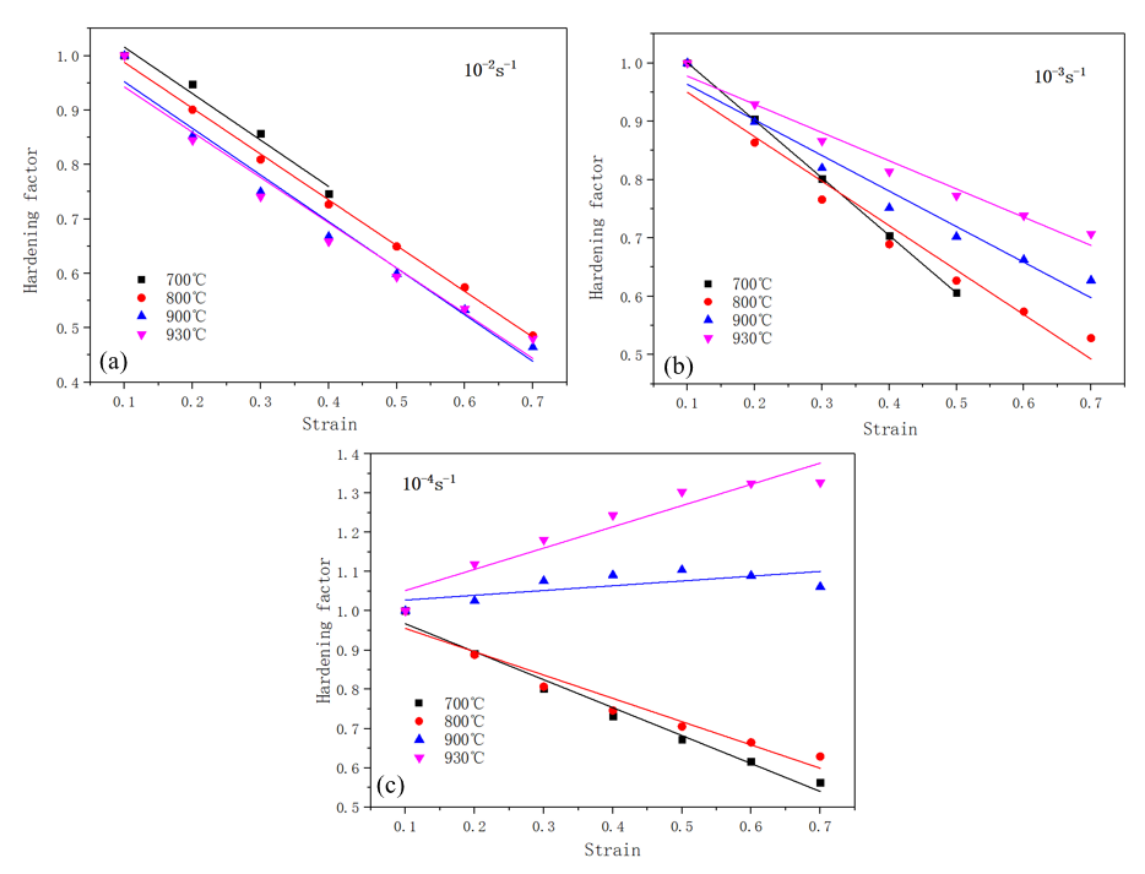
Figure 11. The hardening law for a Ti-6Al-4V alloy at a strain rate of: ( a ) 10 − 2 /s; ( b ) 10 − 3 /s; ( c ) 10 − 4 /s. Table 10. Values for k from Equation (10).